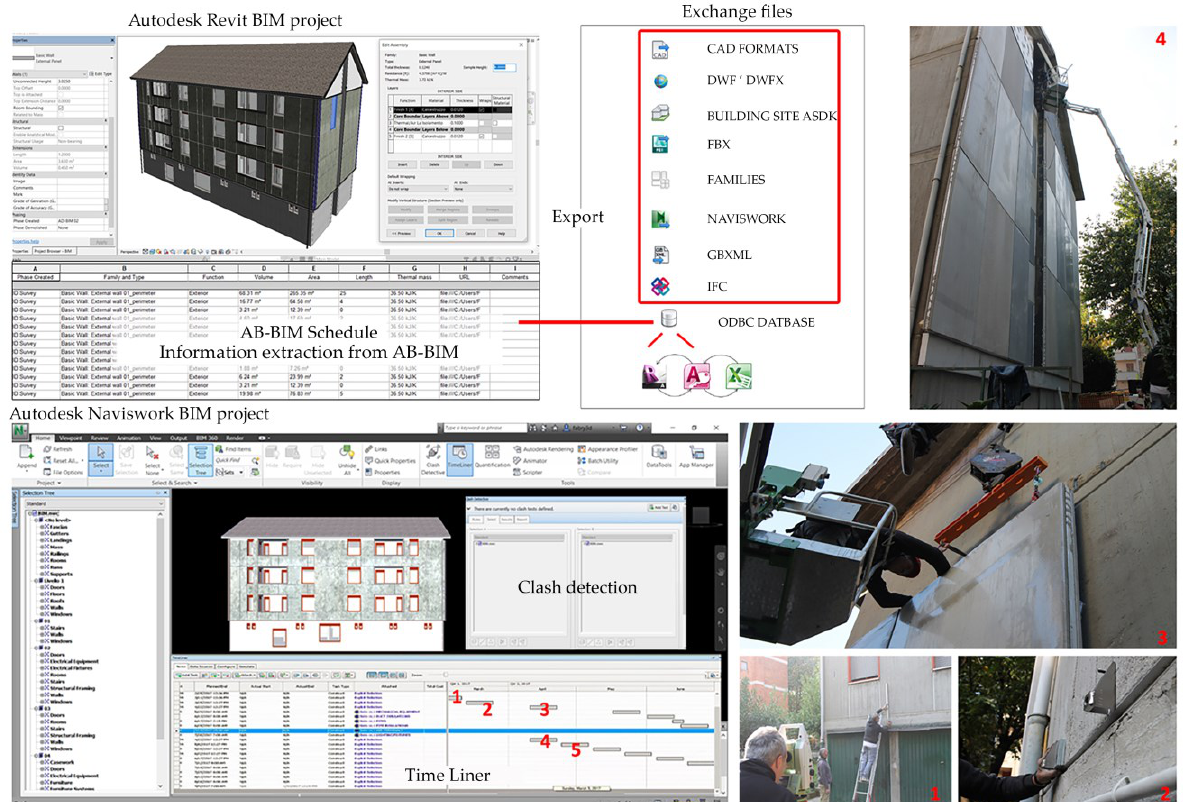
Figure 14. From as-designed to as-built BIM.